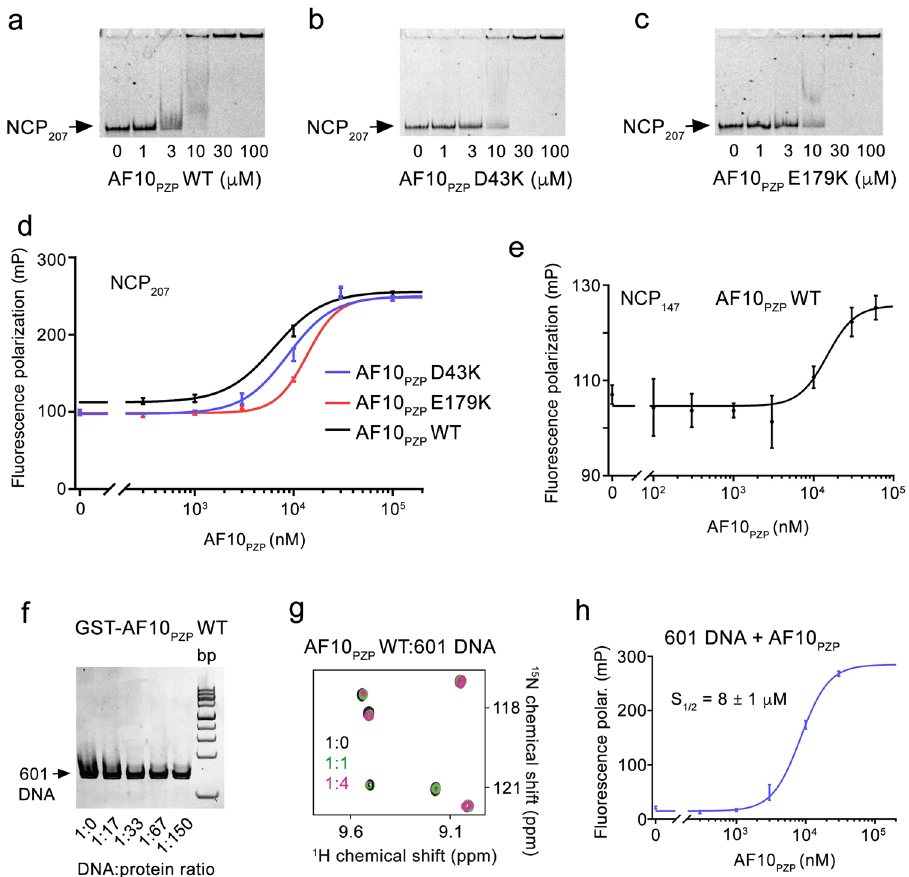
of DOT1L at critical oncogenes and points to the CALM-AF10 fusion as a potential candidate for gene therapy aiming to eliminate the upregulation of oncogenes and reverse